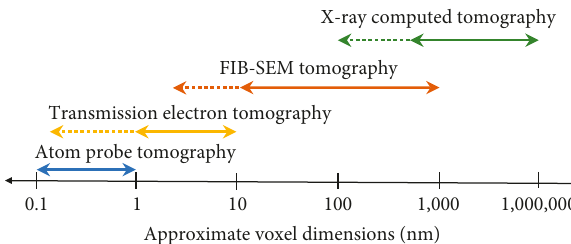
Figure 3: The resolution of modern tomographic characterization methods is displayed as an approximate range. Dash lines represent advanced potential range [26, 43–47].